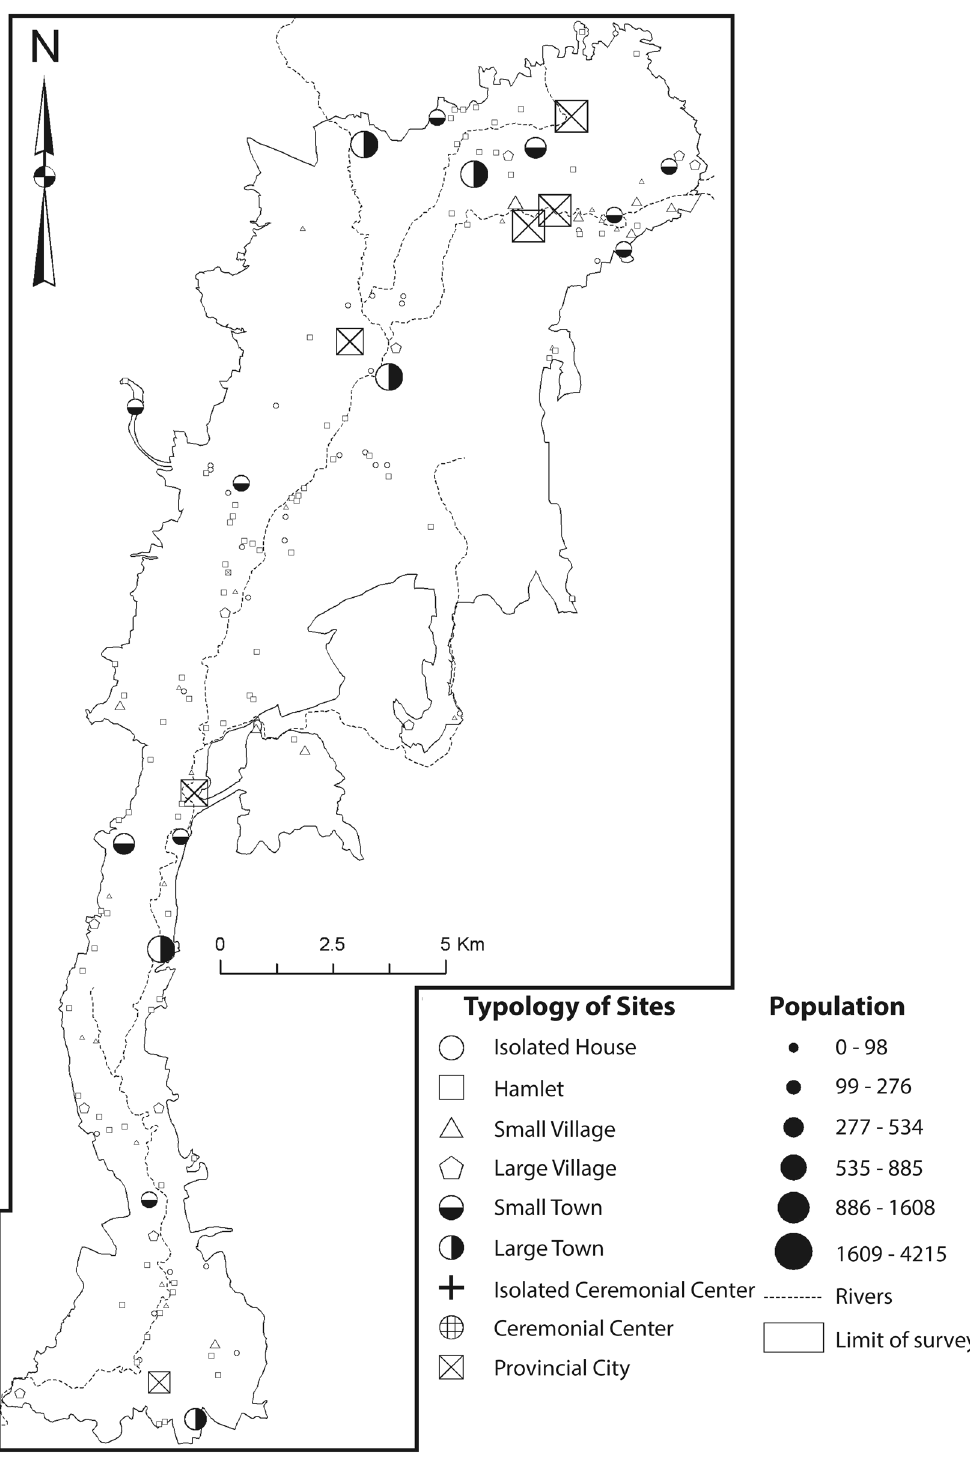
Figure 16: Settlement patterns of the Atlan ( Late Postclassic, A )